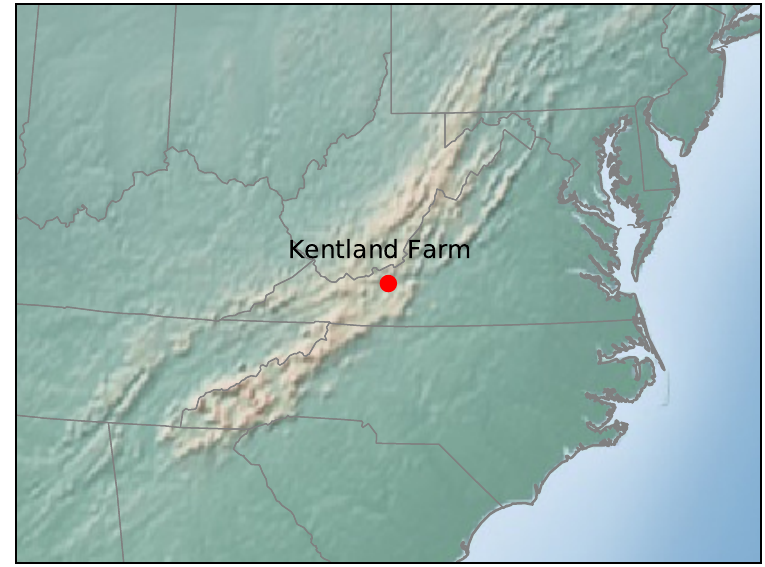
Figure 1. Map of the Mid-Atlantic United States, Kentland Farm in Virginia is shown in